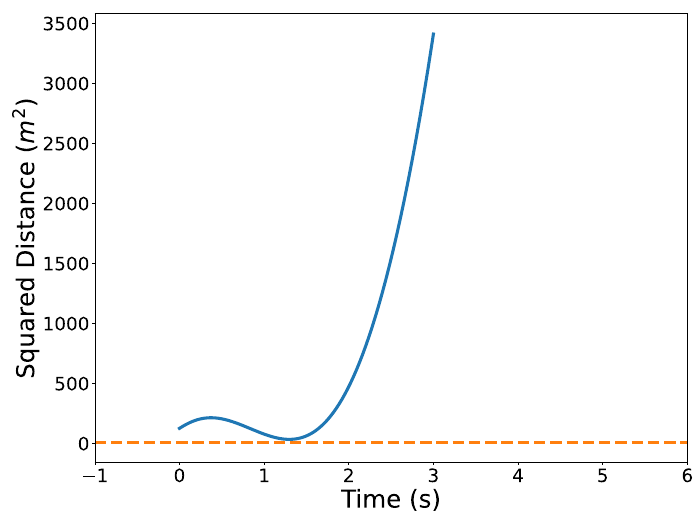
Figure 34. Squared distance between vehicle and